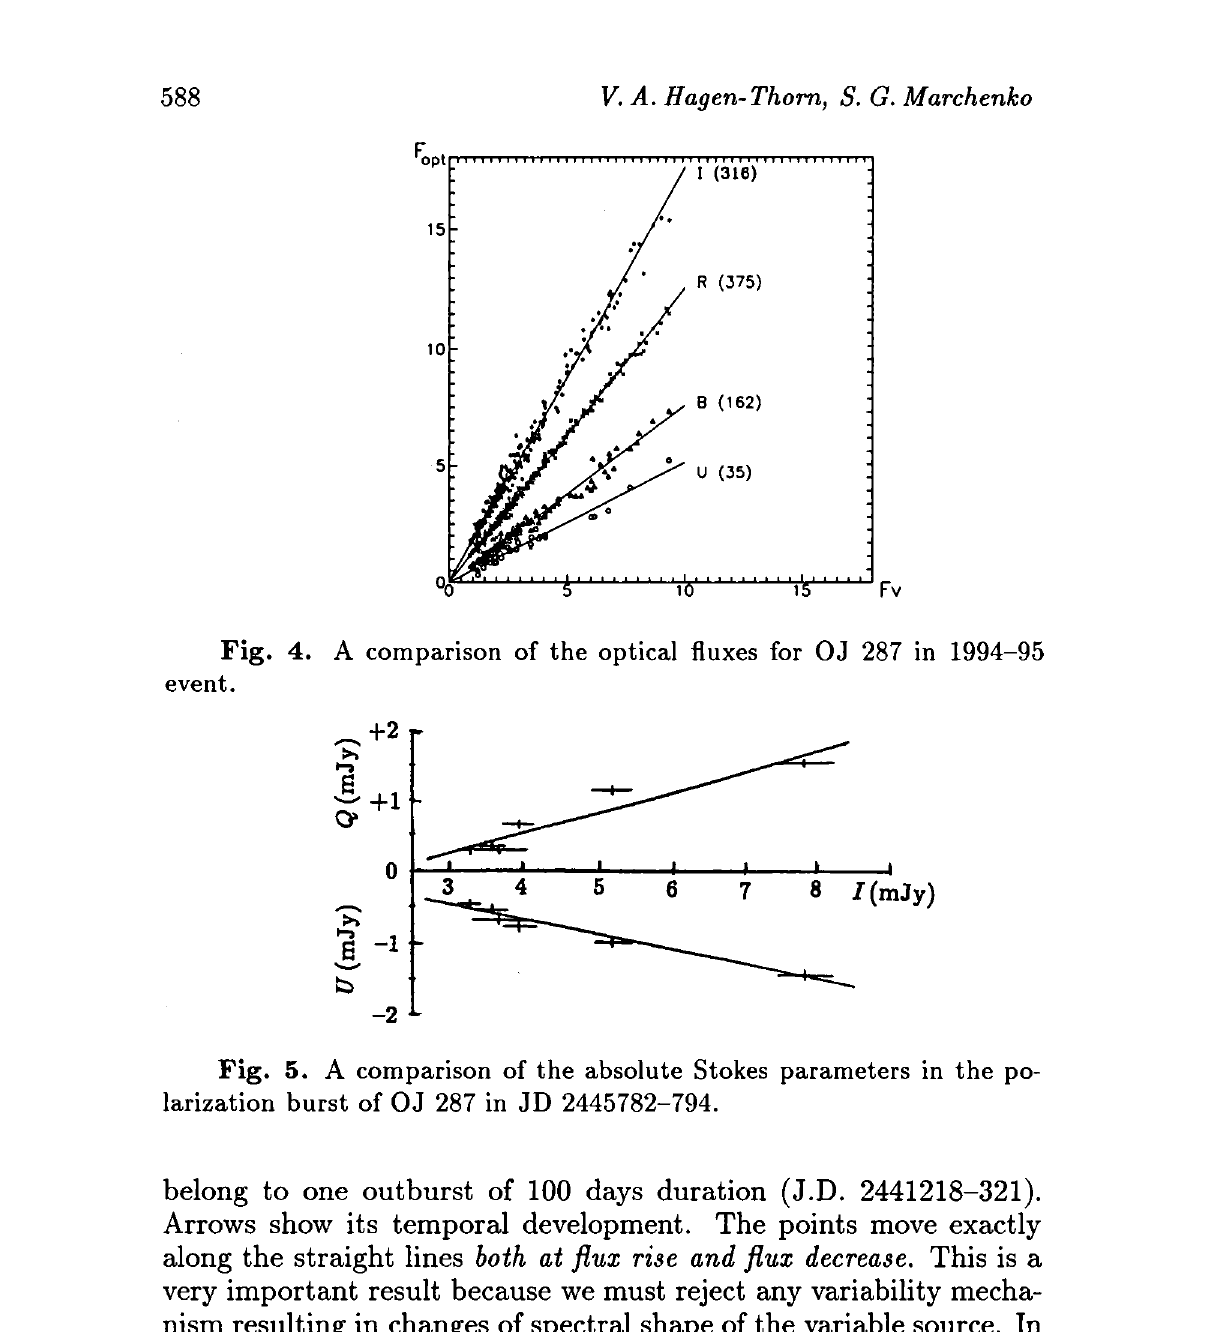
Fig. 5. A comparison of the absolute Stokes parameters in the po- larization burst of OJ 287 in JD 2445782-794. belong to one outburst of 100 days duration (J.D. 2441218-321). Arrows show its temporal development. The points move